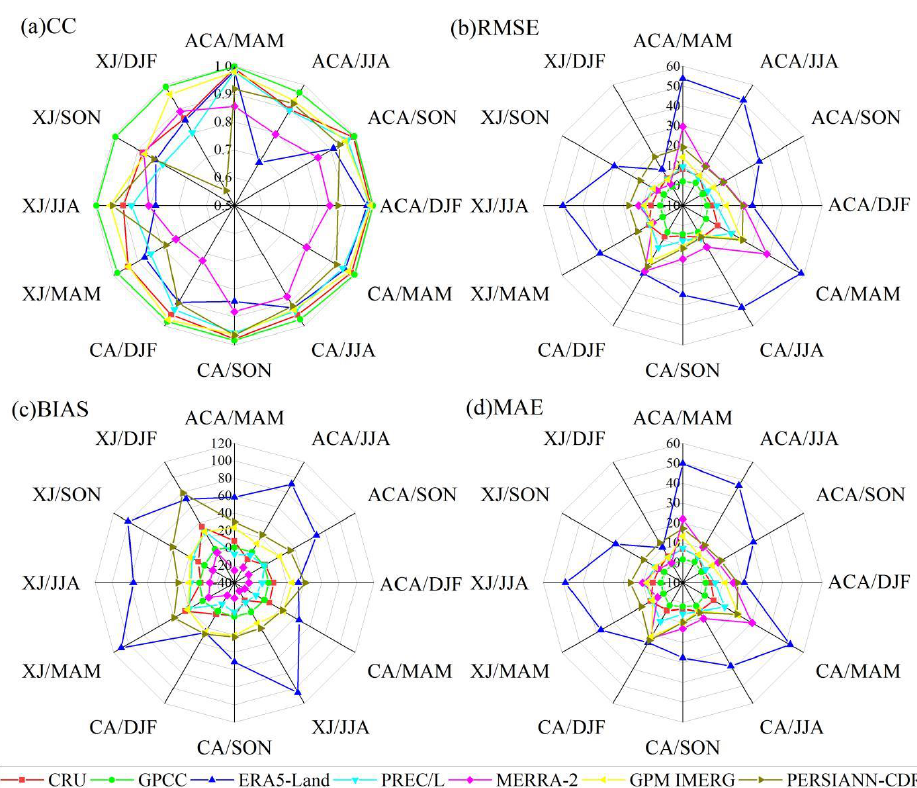
Figure 4. Performance of the seven precipitation products evaluated by the indices of CC ( a ), RMSE ( b ), BIAS ( c ), and MAE ( d ) at the seasonal scale. The first acronym represents regions and the second represents seasons. MAM for spring; JJA for summer; SON for autumn; DJF for winter.